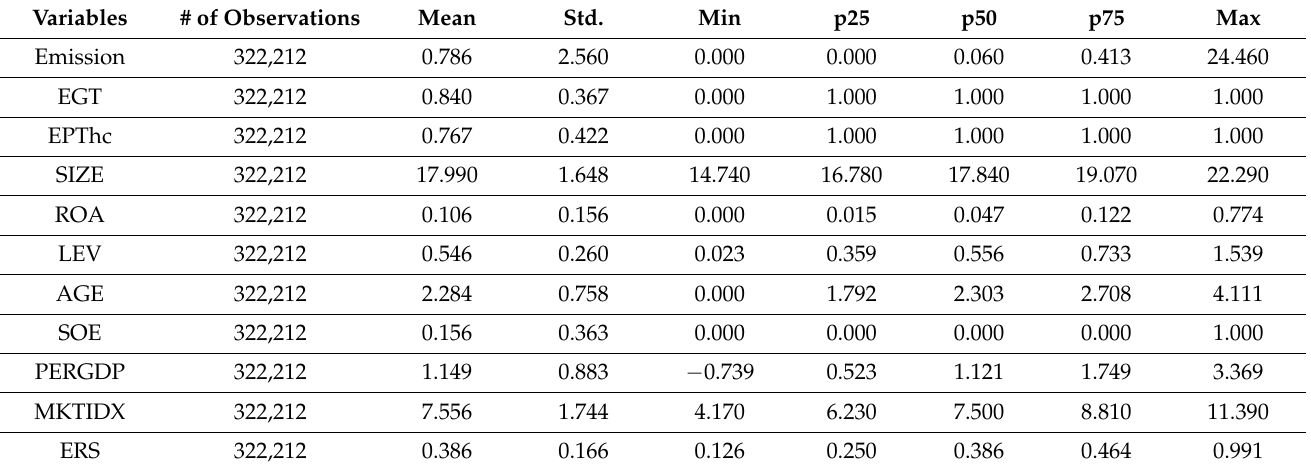
Table 2. Summary